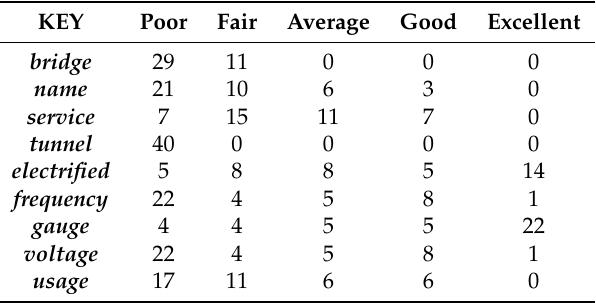
Table 12. Summary of compliance of all cities with suggested tag key combinations for the target tag railway=rail .